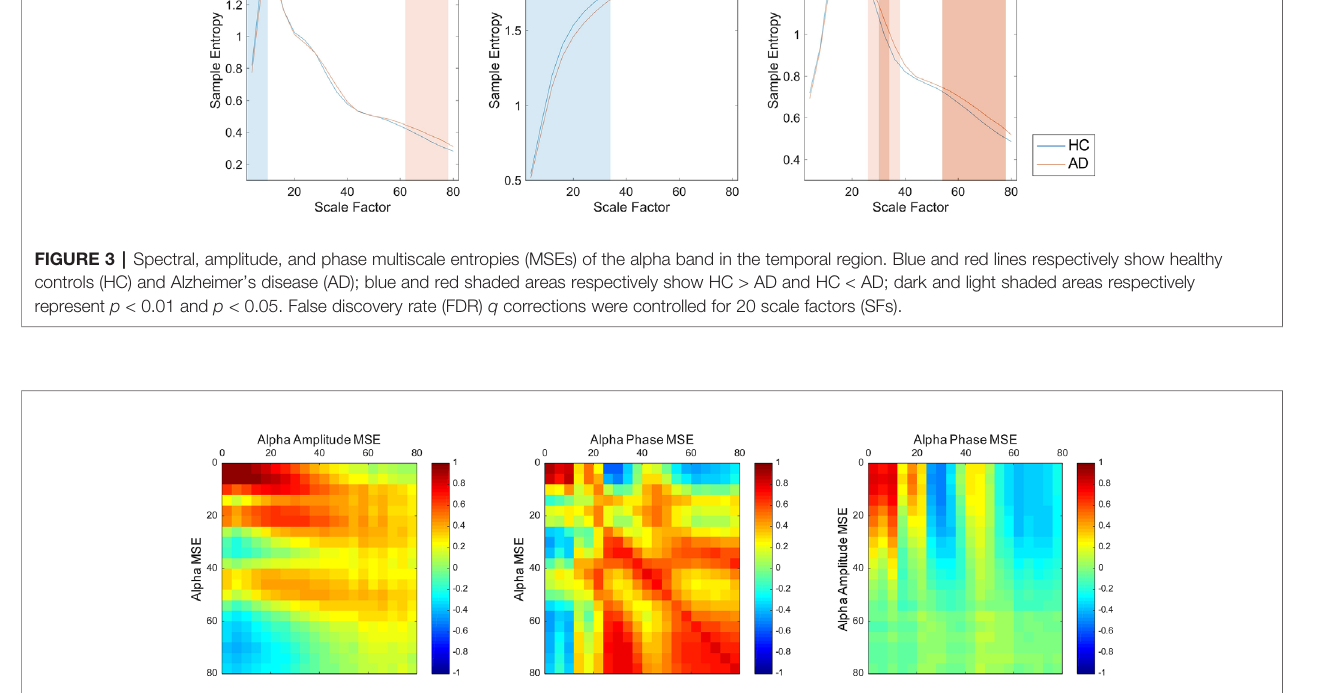
FIGURE 4 | Correlation maps between the spectral, amplitude, and phase SampEn of the alpha band in the temporal region. The spectral complexities were positively correlated with the amplitude complexities on short time scales and the phase complexities on long time scales. Vertical and horizontal axes show scale factors (SFs).